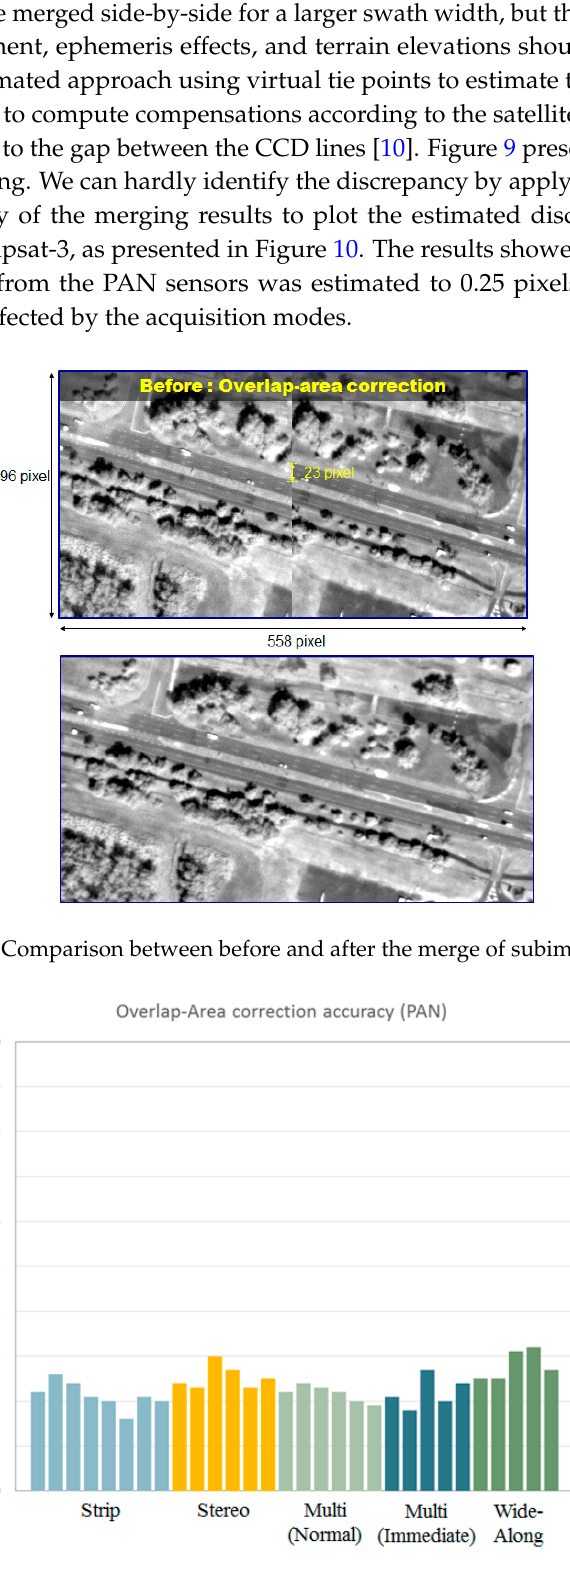
Figure 8. Horizontal accuracy before ( a ) and after the CCD alignment calibration ( b ).